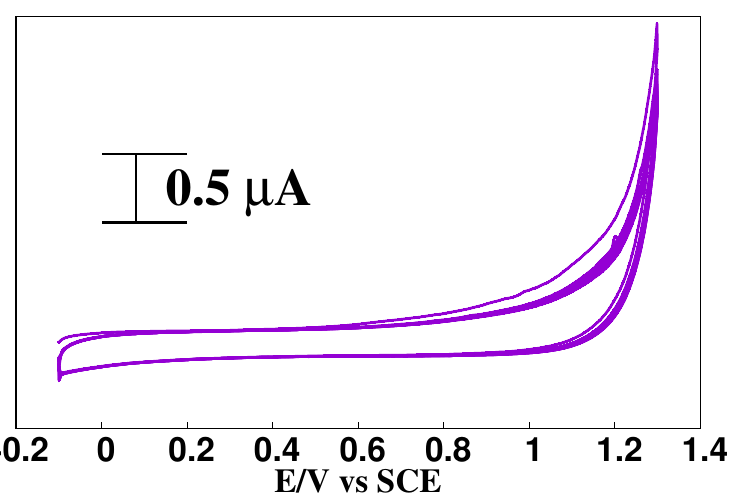
Figure 1. Electrochemical polymerization of l-arginine (1 mM) on CPE in PBS, pH 6.5, for ten multiple